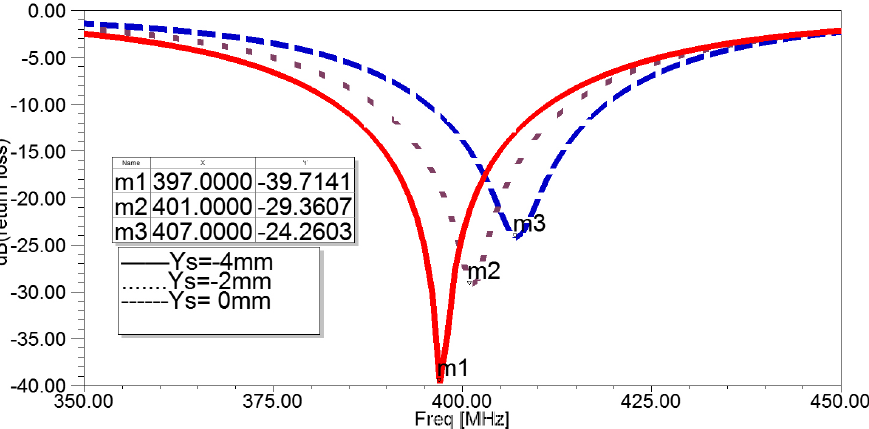
Figure 3. Return losses of the antenna in simulation setups according to different y s .